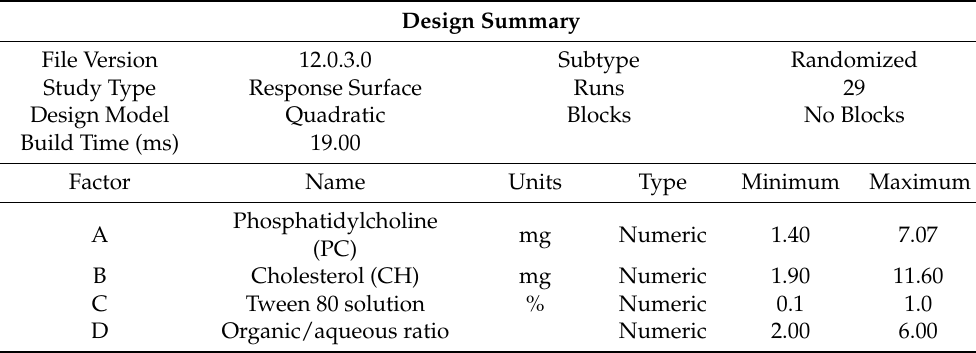
Table 1. Design summary for the optimization of